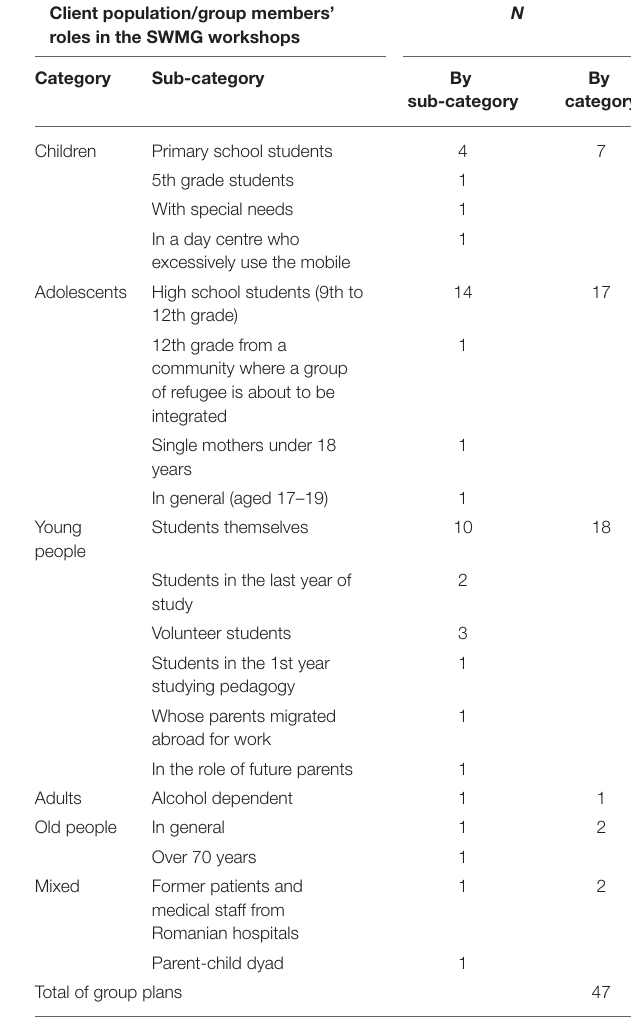
TABLE 6B | The client population the co-leaders addressed in their social work methods with groups (SWMG) workshops in 2019—cohort B. Client population/group members’ roles in the SWMG workshops